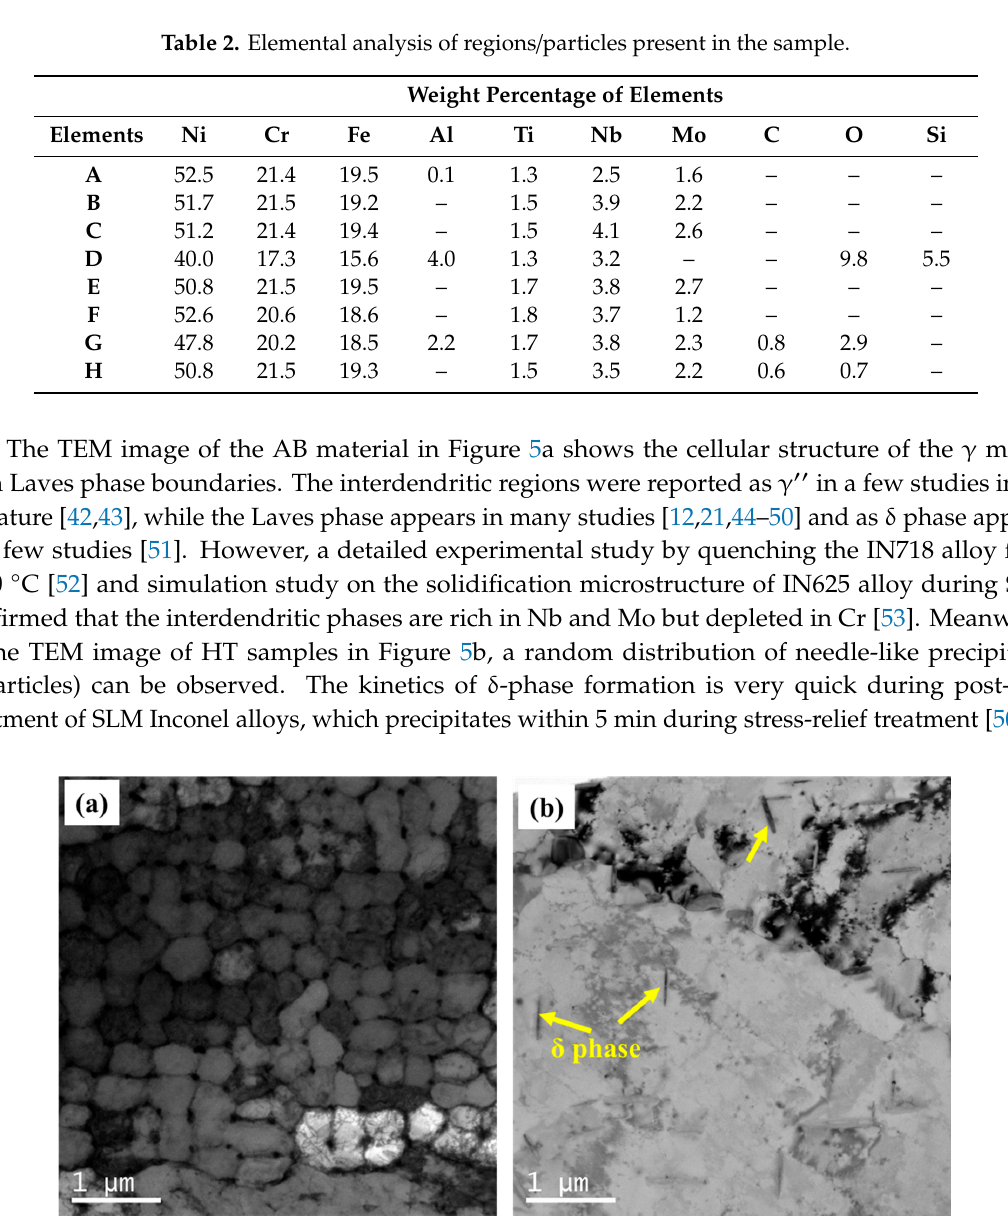
Figure 5. TEM image of ( a ) as-cast material and ( b ) heat-treated material. Table 2. Elemental analysis of regions/particles present in the sample.